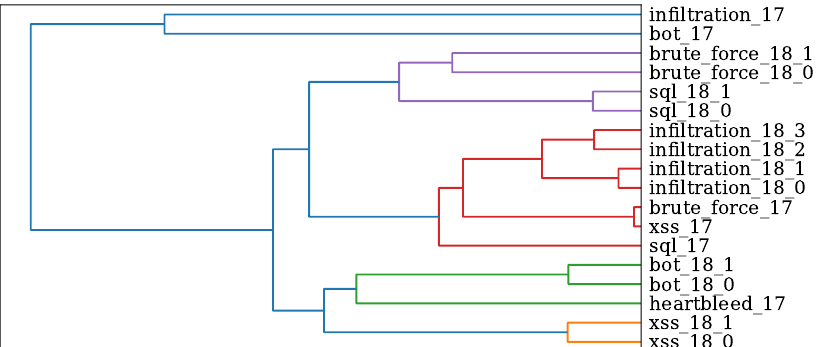
Figure 11. Hierarchical clustering of similarities between a selection of CICIDS2017 and CSE-CIC- IDS2018 attack scenarios based on sig attr for γ =